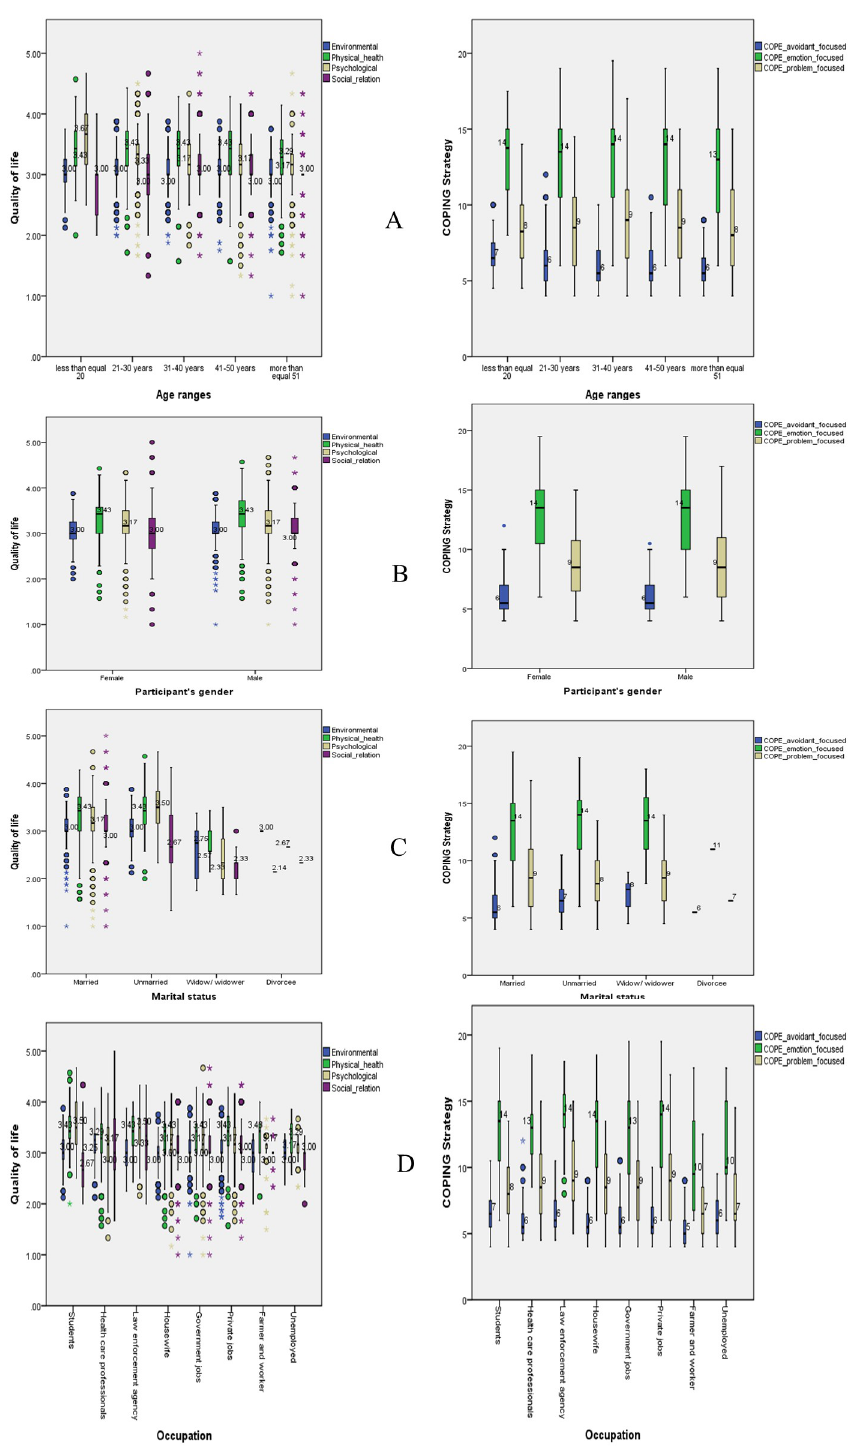
Fig 2. Box plot of COPING and